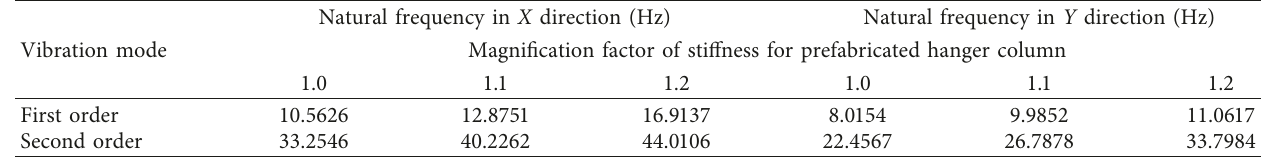
Figure 20: Finite element model. (a) In plan of Y-Z . (b) In space of X-Y-Z Table 3: Natural frequencies obtained with the finite element method.